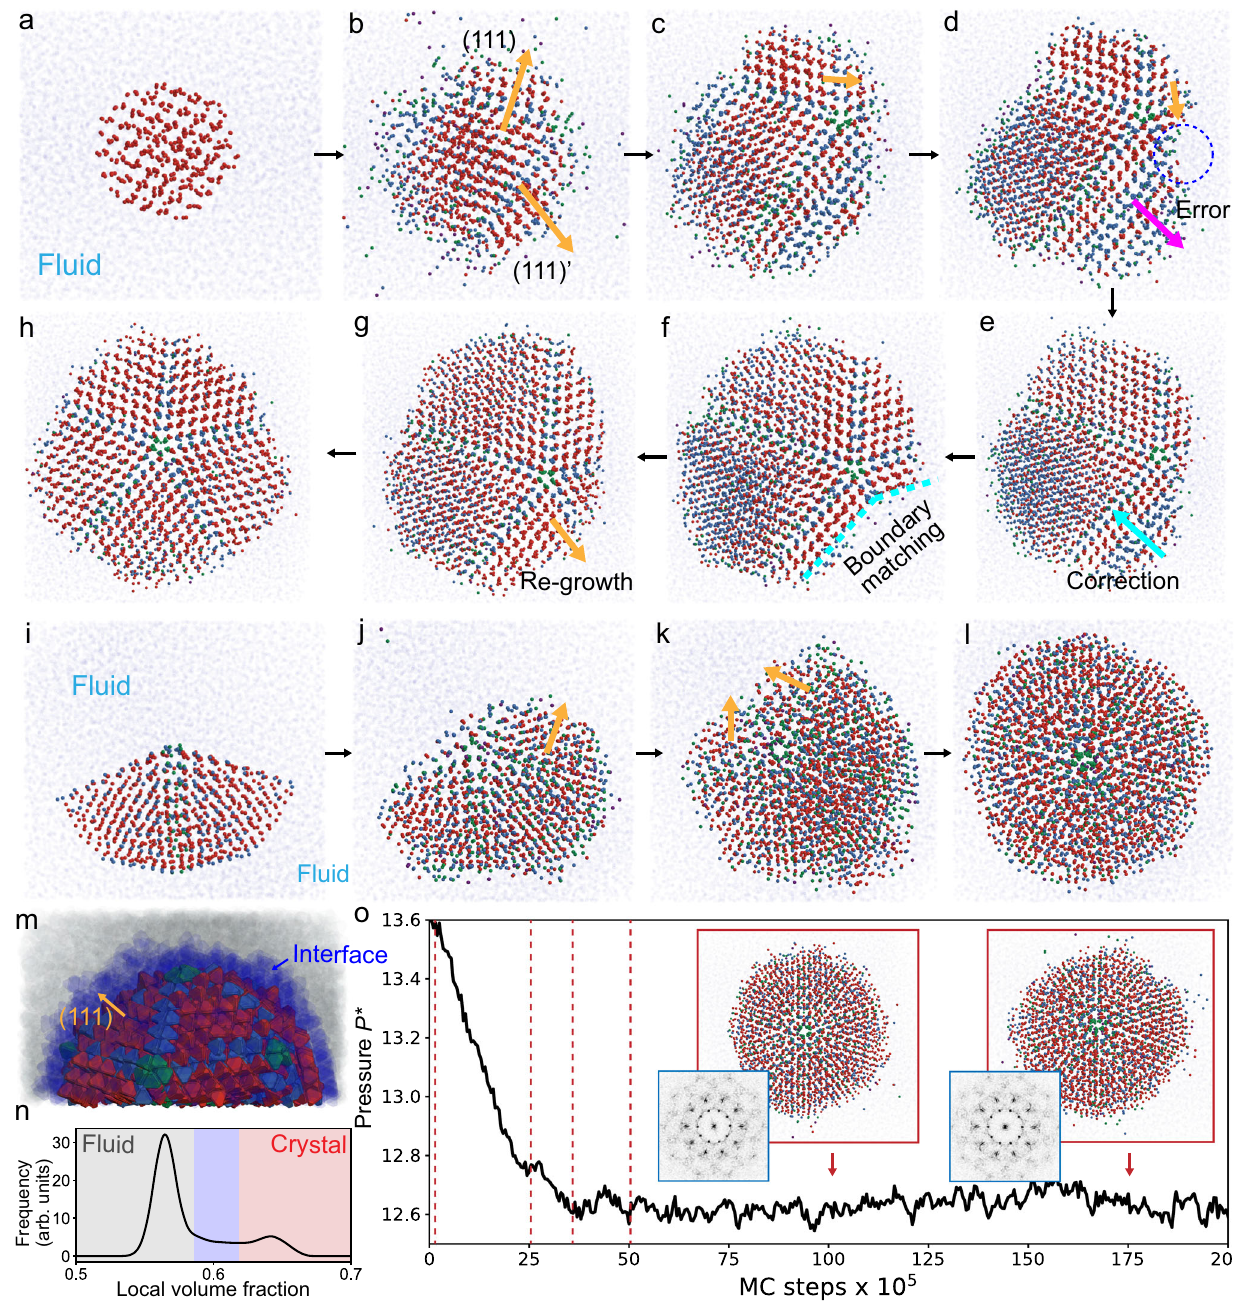
Fig. 3 | Growth process of fi vefold and icosahedral twinned crystals from seed in fl uid. Seed assisted growth of twinned crystals of hard TTs ( a =1 : 20, c =2 : 16) at coexistence between crystal and fl uid ( ϕ =0 : 58). a – h Simulation snapshots show- ing the error-and-repair mechanism of the fi ve-fold twinned crystal. Each TT is represented by a tiny sphere at the TT center of mass. a When a spherical seed of cubicdiamondcrystal( N =500)grows, b twinboundariesareformedalong(111)or its equivalent plane directions. Because the growth of each direction is indepen- dent, c , d an error can occur when stacking sequences of two growth directions mismatch. e The growing direction with the error is re-melted toward its opposite direction( f )untiltheboundarywithitsadjacentplanematches.Oncetheboundary matches, g , h )the fi ve-foldtwinnedcrystalgrowstofullyformthe fi ve-foldtwinned crystal with truncated pentagonal dipyramid (PD) crystal shape. The fi nalcrystal is